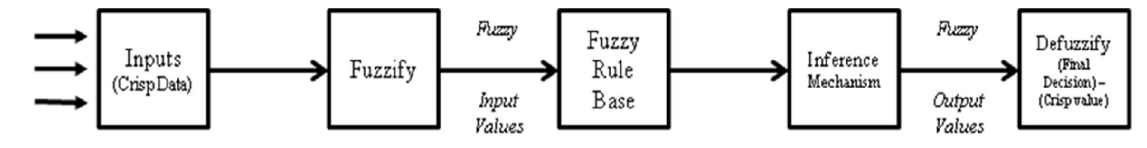
Fig. 6. A Schematic view of Fuzzy logic based decision making